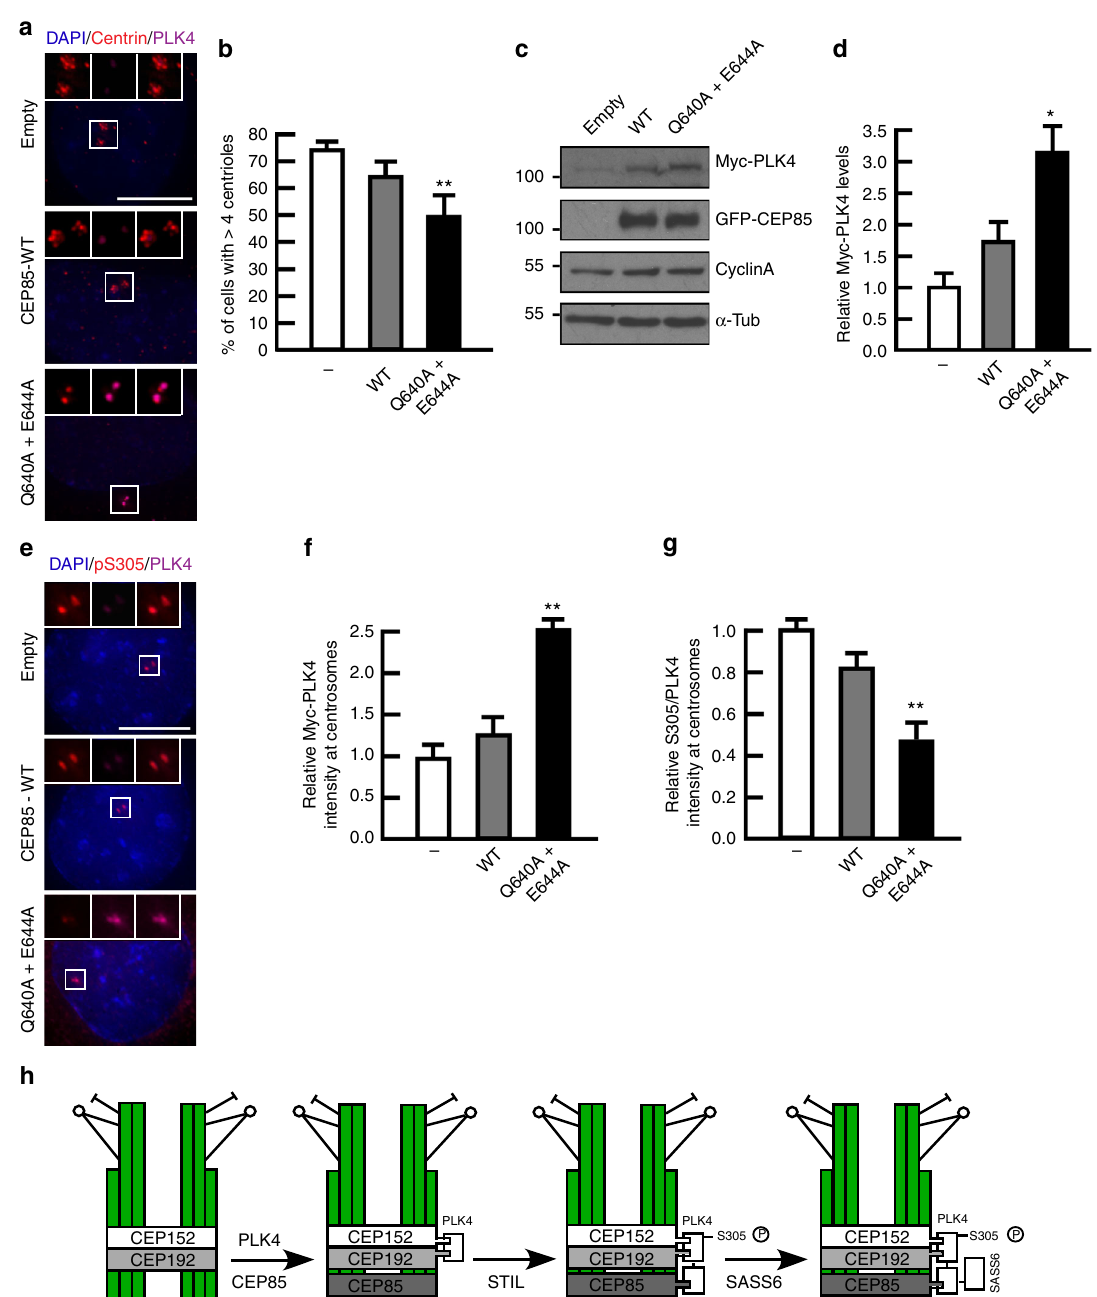
Fig. 7 The interaction between CEP85 and STIL is essential for PLK4 activation and PLK4-induced centriole overduplication. a , b Effect of CEP85 mutations on centriole overduplication. U-2 OS cells conditionally expressing Myc-PLK4 and constitutively expressing GFP-CEP85 (WT and mutant) were used to perform the PLK4-induced centriole overduplication assays. Cells were labelled with DAPI and the indicated antibodies. Scale bar 10 μ m, white boxes indicate the magni fi ed region. b Quanti fi cation showing the percentage of cells with over four centrioles ( n = 100/experiment, three independent experiments). c Western blot analysis indicating the Myc-PLK4 and GFP-CEP85 protein levels using the PLK4 assays described in A. Cyclin A was used as a cell cycle marker and α -tubulin served as a loading control. d Quanti fi cation of protein levels shown in C ( α -tubulin normalized, n = 2/experiment, six independent experiments). e Effect of CEP85 mutations on PLK4 activation. The PLK4-induced centriole overduplication assays were performed as described in a . Selected images showing Myc-PLK4 and PLK4 pS305 labelling. Scale bar 10 μ m, white boxes indicate the magni fi ed region. f , g The graph indicates the relative levels of Myc-PLK4 and the relative ratio of pS305/PLK4 at centrosomes. ( n = 100/experiment, three independent experiments). h A model for how CEP85 operates in the centriole duplication pathway. CEP85 acts downstream of CEP192, CEP152 and PLK4 in centriole duplication. Direct binding of CEP85 to STIL stabilises STIL and facilitates its recruitment to centrosomes. This further facilitates robust PLK4 activation and subsequent centriole assembly. Two-tailed t -test was performed for all p -values, all error bars represent SD, and asterisks for p -values are ** p < 0.01 and * p <